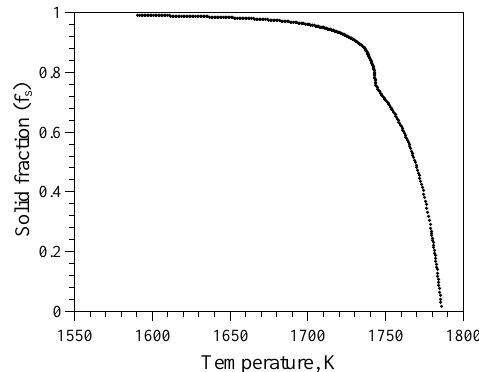
Figure 14. Solid fraction ( f s ) versus temperature for the TRIP steel calculated using the non-equilibrium Scheil-Gulliver solidification